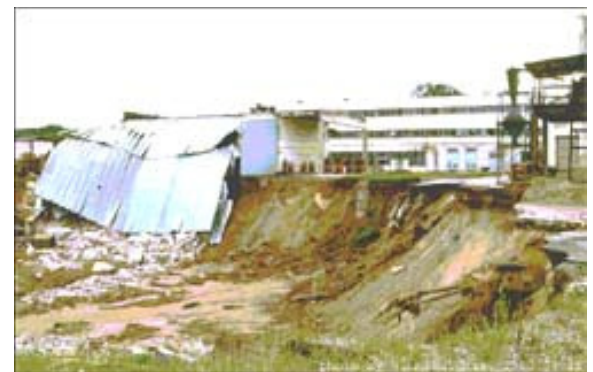
Fig. 1. Scheme of Kaunas with location of active slopes